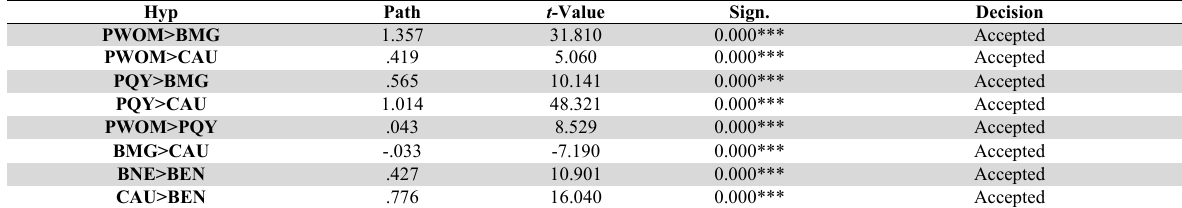
Path Analysis, Regression Weights, P -Values